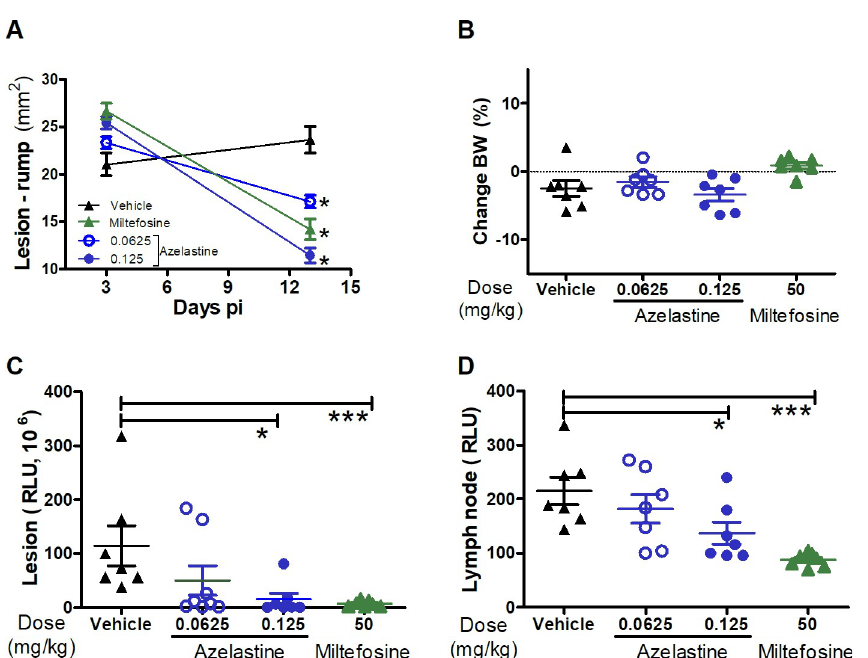
Fig 5. Evaluation of azelastine efficacy in BALB/c mice infected with L . major . Mice (n = 7) were infected intradermically (ID) with 10 7 metacyclic promastigotes of L . major transfected with the luciferase gene. Lesion size (area in mm2 = length x width) was measured using a digital caliper (A). Body weight change was estimated as a major sign of toxicity (B). The parasite load at the infection site (C) and draining lymph nodes (D) was determined in vivo using the IVIS spectrum imager. Animals received 3 ID injections of azelastine or vehicle (control) from day 3 to 10 p. i. Another group of mice was treated orally with miltefosine 50 mg/kg for 10 days as a positive control of parasite suppression. The figures show mean values and their standard deviation (SD). Representative data of 2 independent experiments. P value: � < 0.05; ��� < 0.001. The statistical significance of the data was determined using the t test.